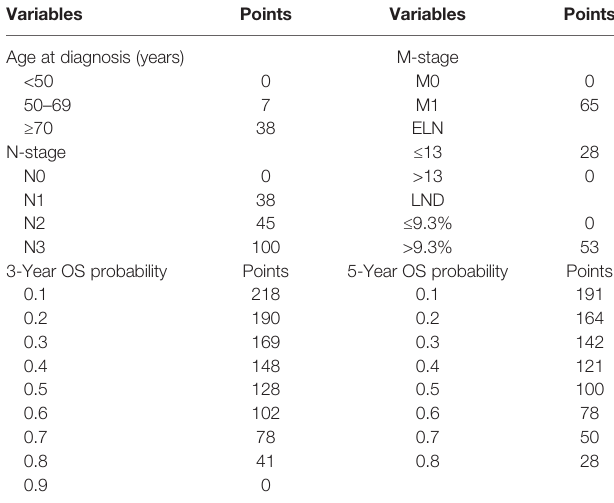
TABLE 4 | Nomogram scoring